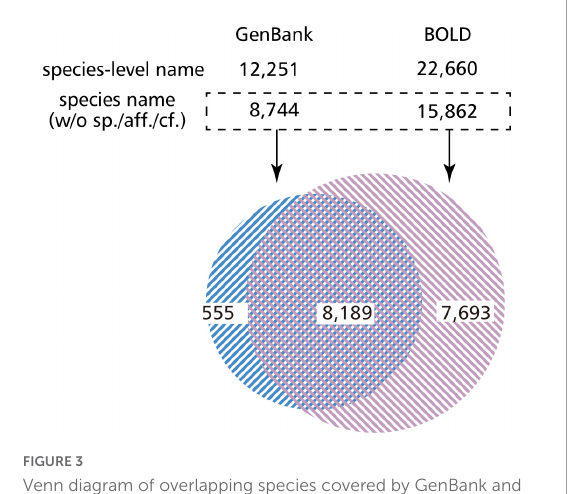
FIGURE3 Venn diagram of overlapping species covered by GenBank and BOLD DNA barcode entries. We investigated how many species do BOLD and GenBank cover, and how many species overlap in these databases with regard to the fish DNA barcode data. Even if there are data in the species field, they are often not identified to the species level (such as sp. or aff.). Most of the species covered by GenBank are also covered by BOLD, which may be because BOLD imports GenBank